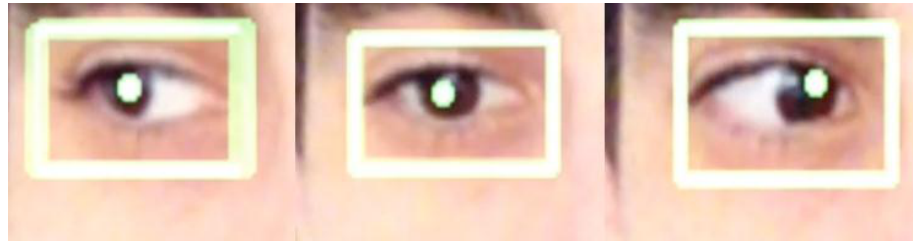
Figure 18. Gaze to the left, center and